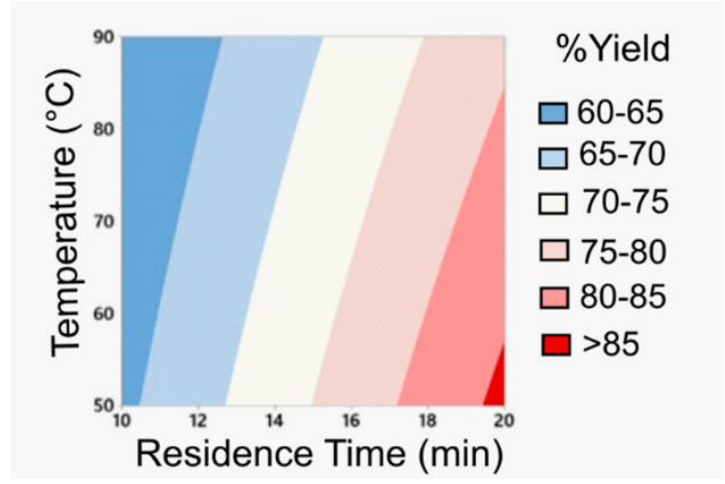
Figure 4. Optimization process for the amidation step exploiting DoE; Reprinted with permission from ref. [75]. Copyright 2020 American Chemical Society.